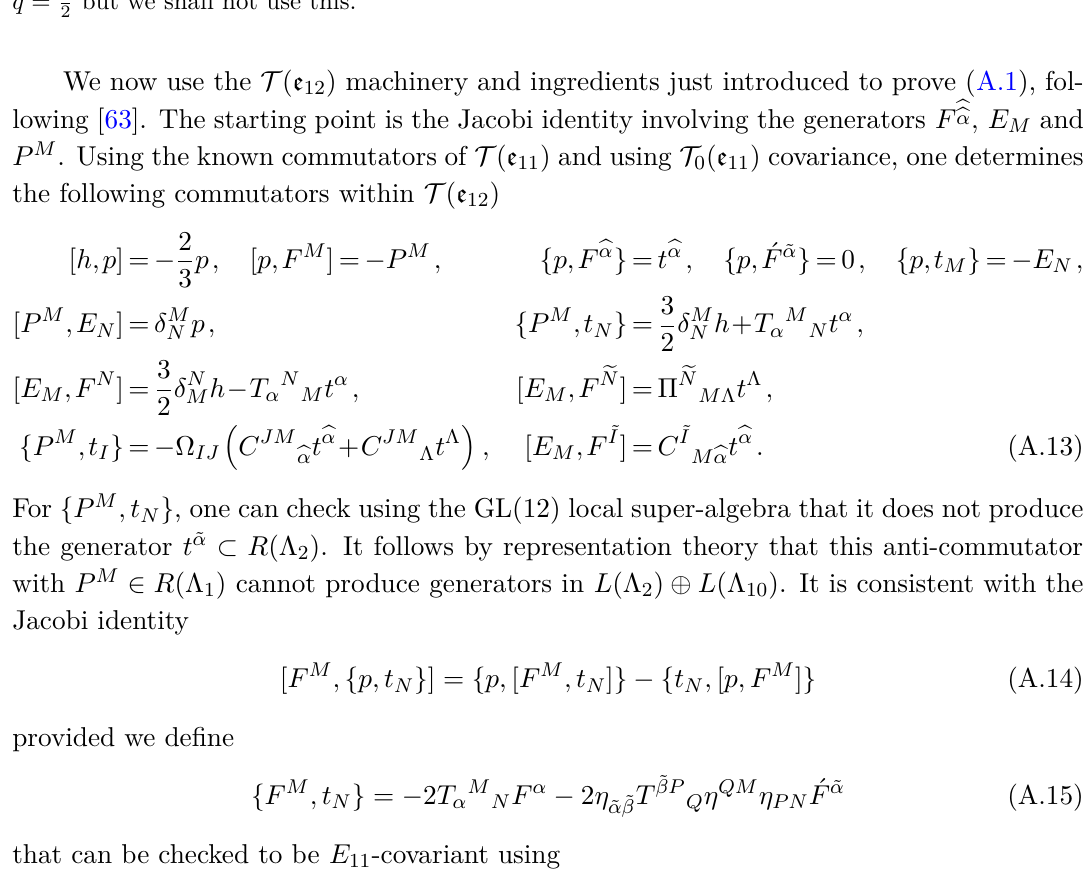
) . The involution for T ( e 4